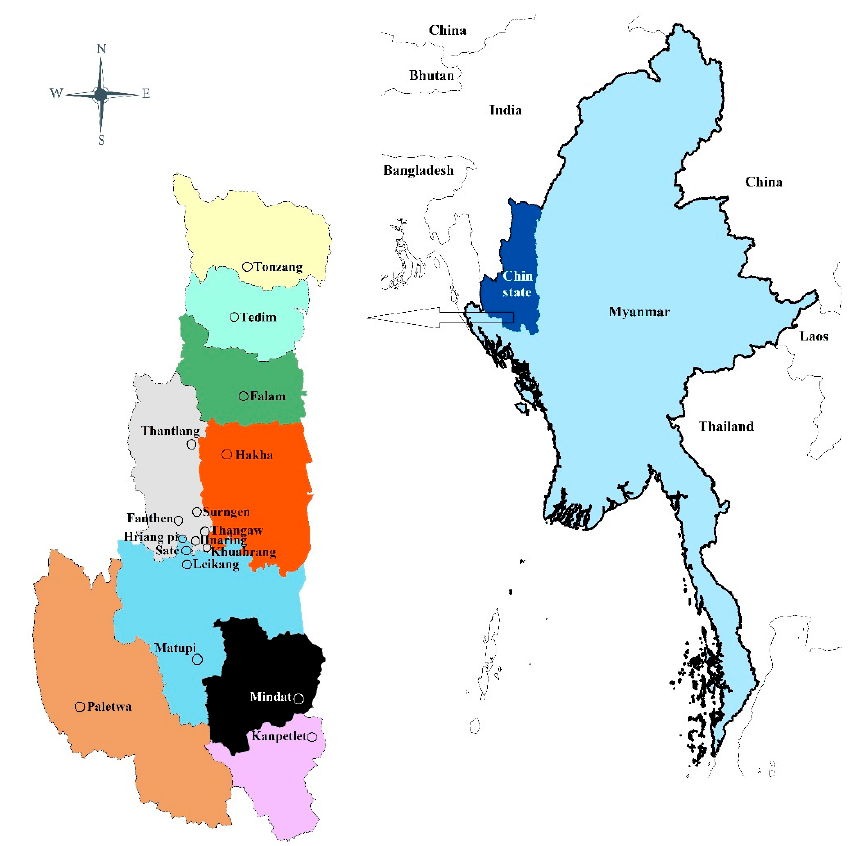
Figure 1. Location of Chin State in Myanmar (deep blue color on the left) and the communities, including Falam, Hakha, Kanpetlet, Lutuv (Hnaring, Hriangpi, Khuahrang, Leikang, Sate, Surngen, Thangaw, Matupi, Mindat, Tedim, and Thantlang, where ethnobotanical data related to the traditional textile dyeing plants were collected